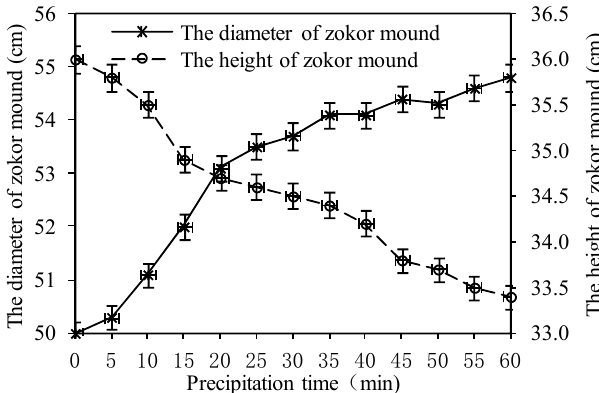
Figure 7. Variation in the diameter (left axis, solid line) and height (right axis, dashed line) of zokor mounds with precipitation. Results are based on a rainfall intensity of 15 mm h − 1 on a 30° slope.